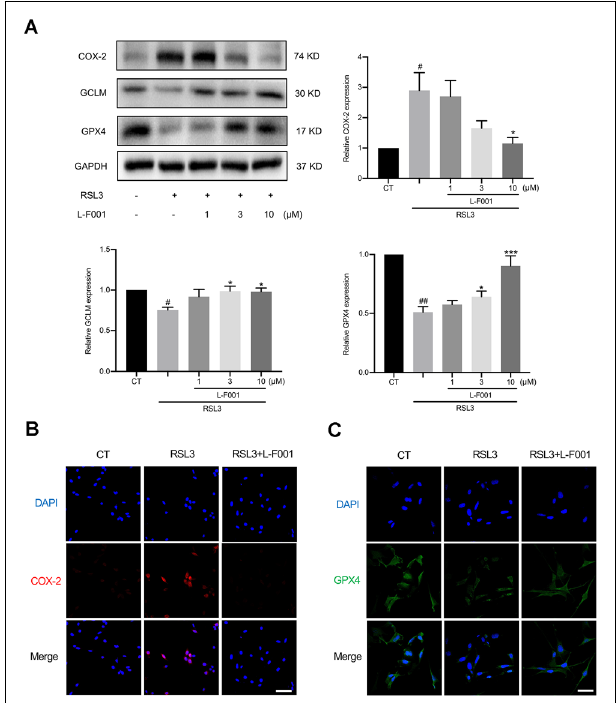
FIGURE 3 | L-F001 affects the levels of lipid peroxidation-related protein proteins in HT22 cells. HT22 cells were treated with 0.1 µ M RSL3 alone, and then added L-F001 (1–10 µ M) at 37 ◦ C for 24 h. ( A) The levels of COX-2, GCLM, and GPX4 were measured by Western blot, and the amount of COX-2, GCLM, and GPX4 were estimated by densitometric analysis of each protein band ( n = 3). (B,C) Cells were immunofluorescence stained with anti-COX-2 and GPX4 antibodies. Nuclear counterstaining was done with DAPI (Scale bar = 100 µ m). # P < 0.05 and ## P < 0.01 compared with the control group. * P < 0.05 and *** P < 0.001 compared with the RSL3